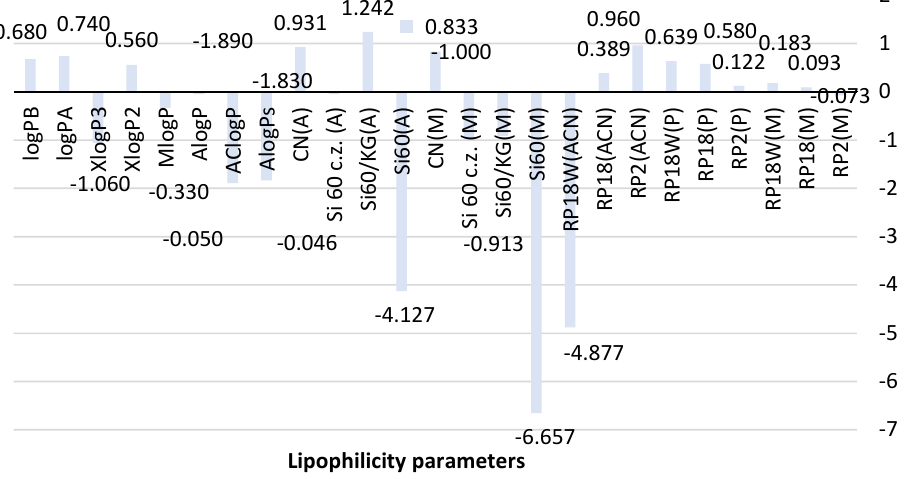
Figure 2. Comparison of lipophilicity parameters of metformin obtained using different methods. ACN-acetonitrile; A-acetone, M-methanol, P-propan-1-ol-organic modifier used in the mobile phase, Si60-silica gel plates, Si60c.z.-silica gel plates with the concentrating zone, Si60/KG-chromatographic plates precoated with the mixture of silica gel60 and Kieselguhr F 254 , CN-silica gel modified with cyano groups.